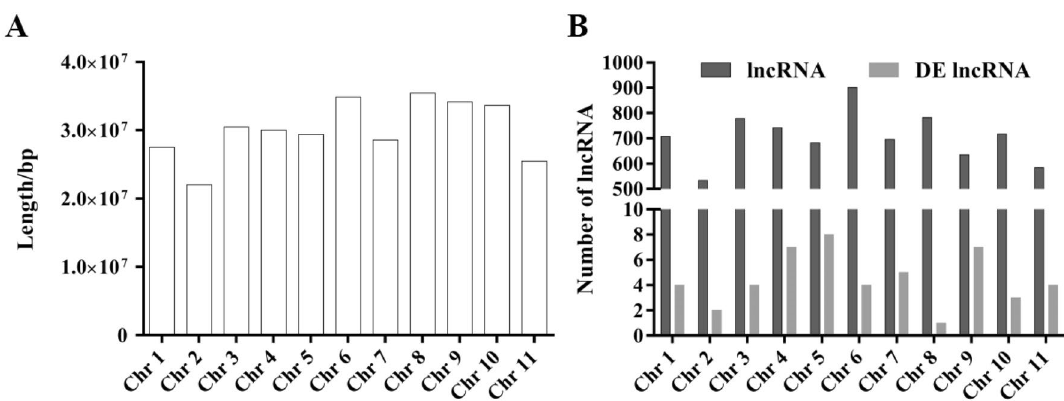
Figure 2. Chromosome length ( A ) and the distribution of long noncoding RNAs (lncRNAs) and chromosome location of the identified DE lncRNAs ( B ). DE: differentially expressed, Chr: chromosome, bp: base pair.